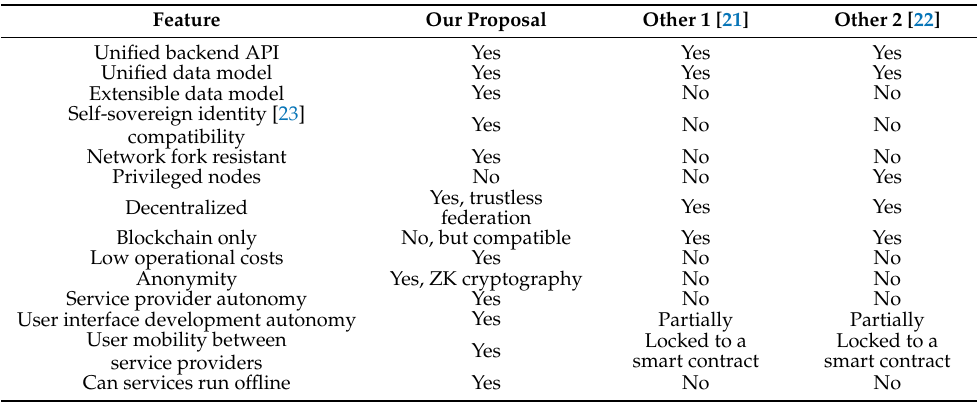
Table 2. Feature comparison between different